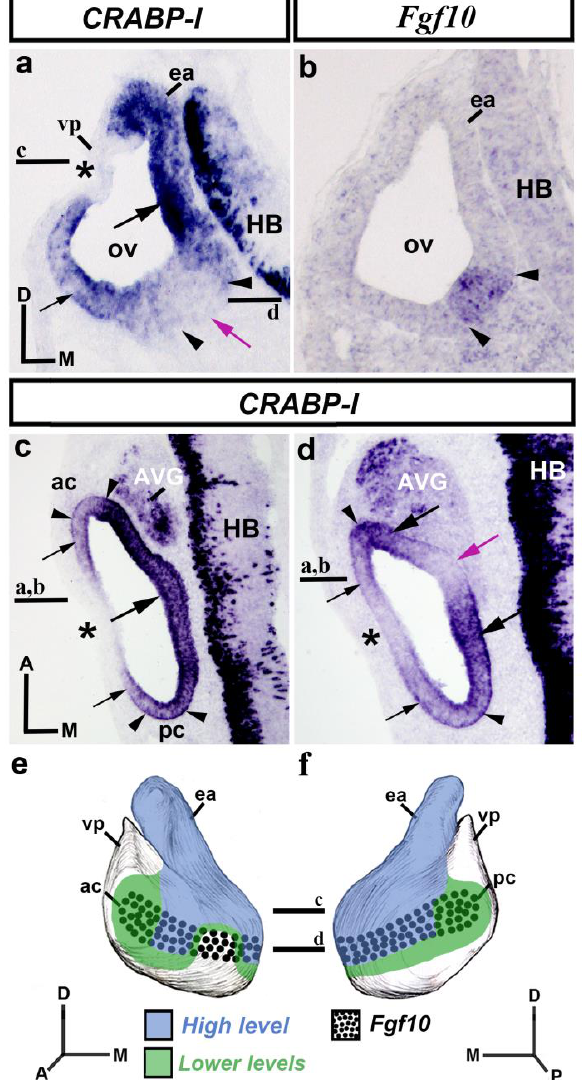
Figure 1. CRABP-I expression patterns at the otic vesicle stage, HH18-20. Transverse ( a , b ) and horizontal ( c , d ) sections treated with the CRABP-I probes. The patterns are heterogeneous, with higher levels in the entire dorsomedial portion (large black arrow in ( a , c )) facing the hindbrain (HB; ( a,c )), and including the growing endolymphatic apparatus (ea; ( a )). Weaker levels of CRABP-I expression were observed in part of the lateral wall of the otic vesicle (small black arrows in ( a , c , d )), including the anterior and posterior cristae (ac and pc; between arrowheads in ( c )). A gap in expression was observed in the dorsolateral and lateral walls (asterisks in ( a , c , d )). In the ventromedial aspect of the otocyst, there is an area without CRABP-I expression (purple arrows in ( a ,d)). The Fgf10 -positive pro-sensory domain (between arrowheads in ( a – d )) showed different levels of CRABP-I expression (ac and pc in ( c ); large black arrows in ( d )) or non-expression (purple arrows in ( a , d )). The AVG shows CRABP-I positive cells ( c , d ). ( e , f ), 3D CRABP-I expression pattern diagrams, showing anterior ( e ) and posterior ( f ) views of the otic vesicle. The horizontal sections were indicated. Dotted areas represent the pro-sensory Fgf10 -positive domain. For the abbreviations, see the list. Orientation: A, anterior; D, dorsal; M, medial; P, posterior.